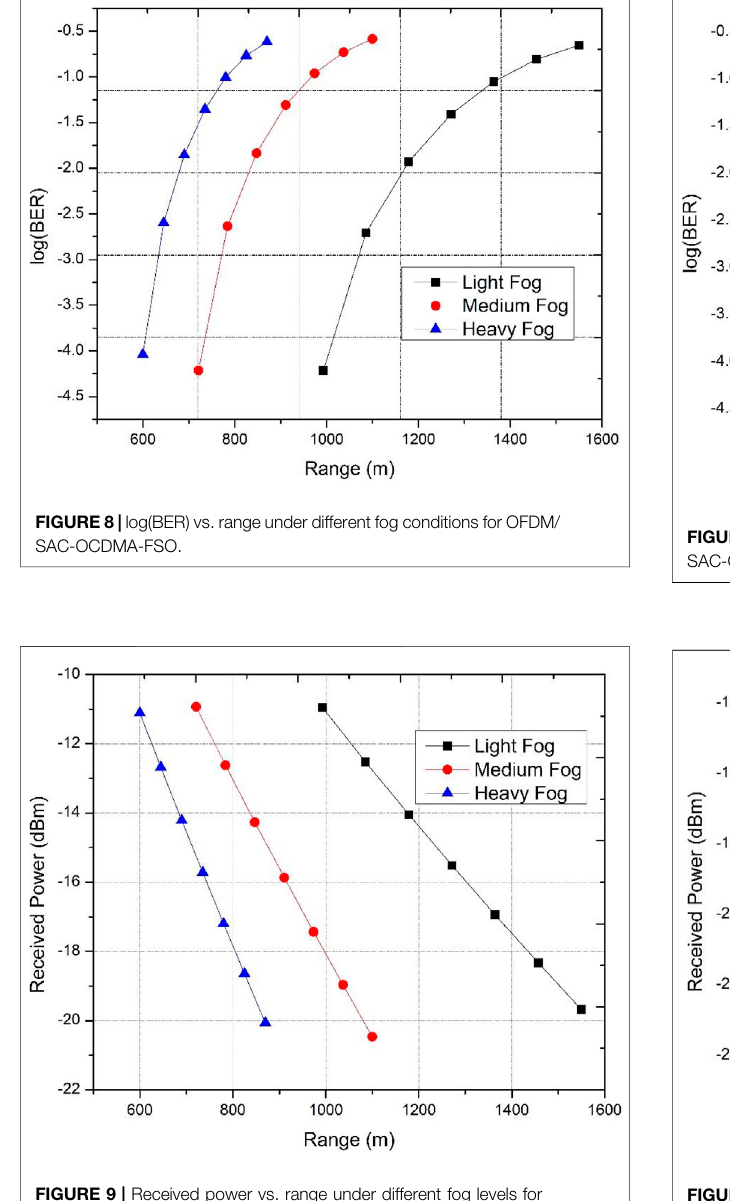
FIGURE 11 | Received power vs. range under dust storm conditions for OFDM/SAC-OCDMA-FSO.